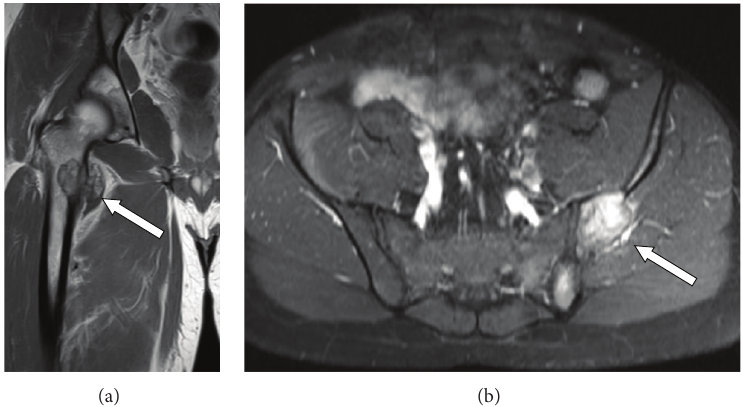
Figure 3: Magnetic resonance imaging: (a) coronal image of the right proximal femur shows the soft tissue involvement (arrow) of the lesser trochanteric region, and (b) axial image of the pelvis demonstrates the soft tissue involvement of the right gluteal region (arrow) nearby the iliac wing and the sacroiliac joint.